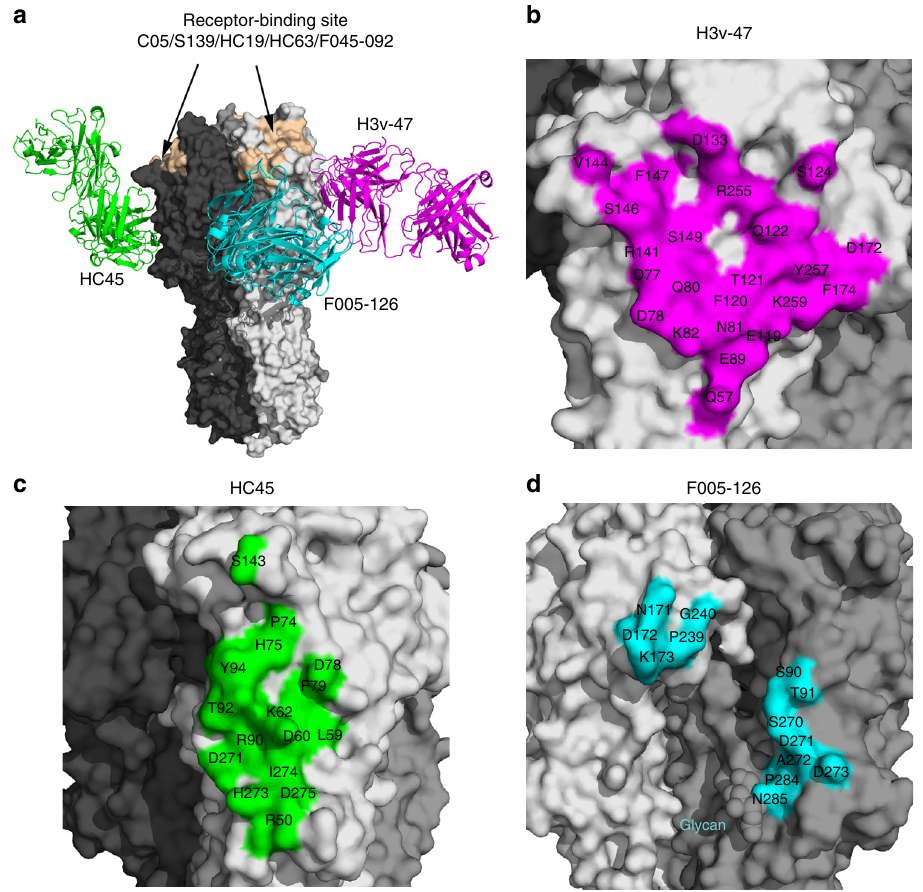
Fig. 7 H3v-47 binds a unique epitope in the HA head domain. a Comparison of the binding site of H3v-47 (in magenta) wih structurally characterized H3- binding antibodies binding to the HA head. The three protomers of the HA trimer are shown as surface in light, middle or dark gray, respectively. The HAs from all these HA-antibody complexes are aligned. These antibodies include HC45 (PDB code 1QFU, green) and F005-126 (PDB code 3WHE, purple) binding to the globular head below the receptor-binding site (RBS). For comparison, mAbs C05 (PDB code 4FP8), S139 (PDB code 4GMS), HC19 (PDB code 2VIR), HC63 (PDB code 1KEN), and F045-092 (PDB code 4O58) all bind to the RBS. Because the epitopes of the RBS-binding antibodies overlap extensively, their epitopes (in wheat) are depicted approximately around the RBS, to indicate their relative location compared to H3v-47. b – d Comparison of the detailed epitopes recognized by H3v-47 ( b ), HC45 ( c ), and F005-126 ( d